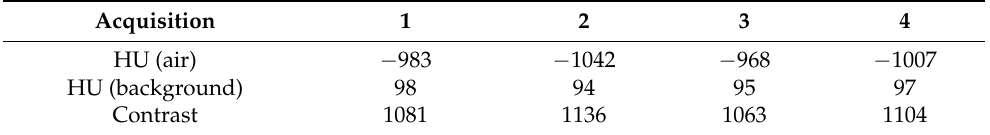
Table 2. HU mean values in the air insert and in the background were measured for the CTDI vol of 10 mGy. The acquisition number correspondence is indicated in Table